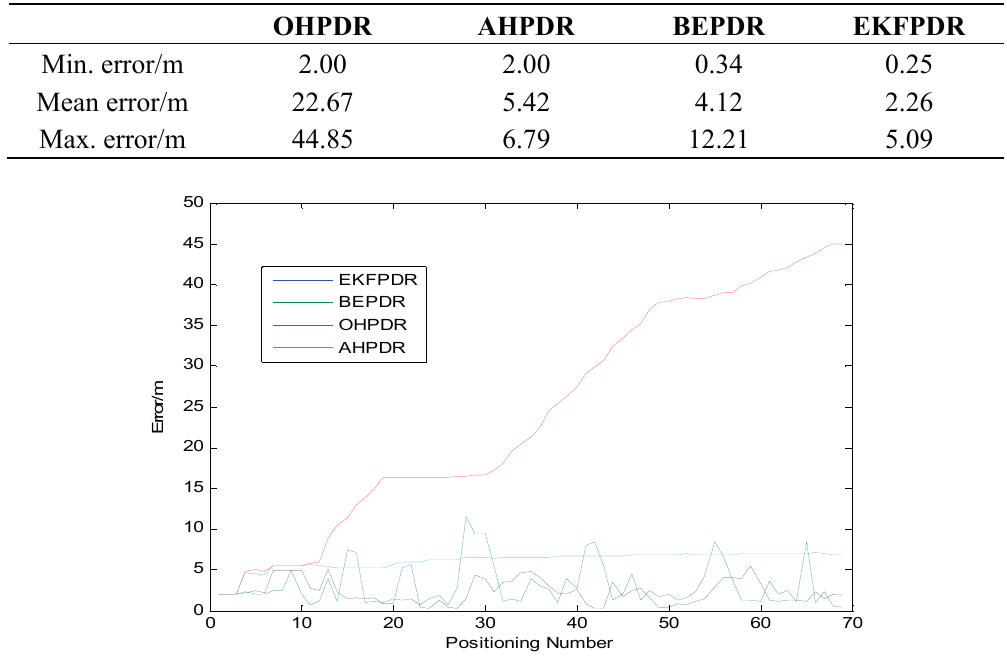
Table 4. Positioning error analysis for different solutions associated with PDR.